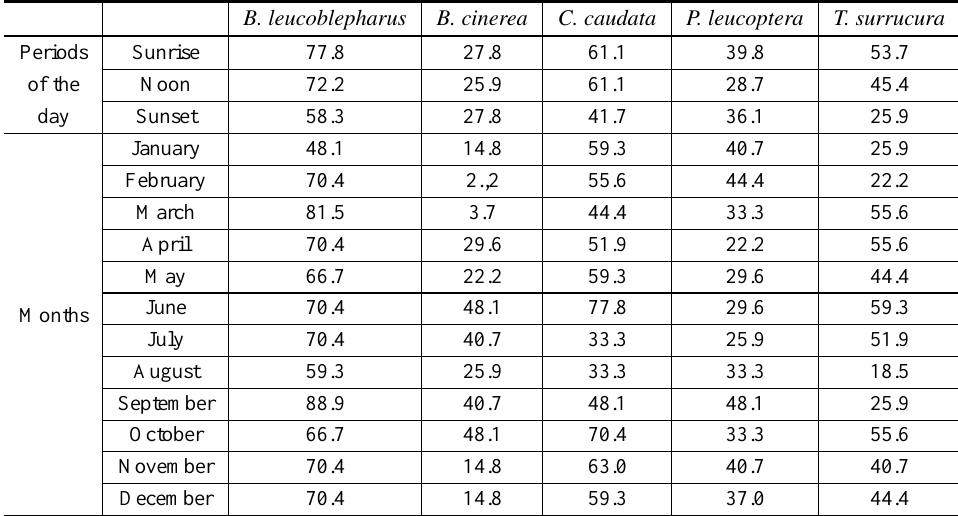
Percentages of detected positive responses to playback according to each tested period of the day and month for the five studied species.